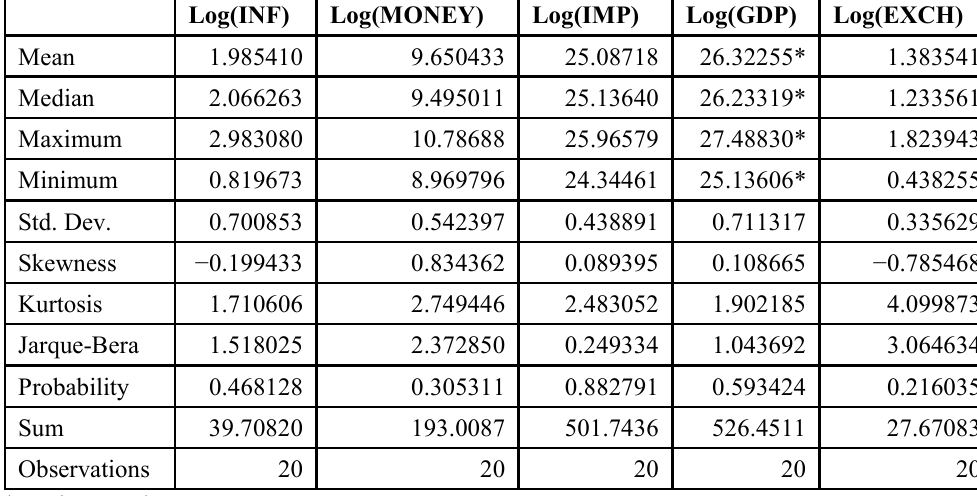
Table 3. Descriptive Statistics of Variables in the Study